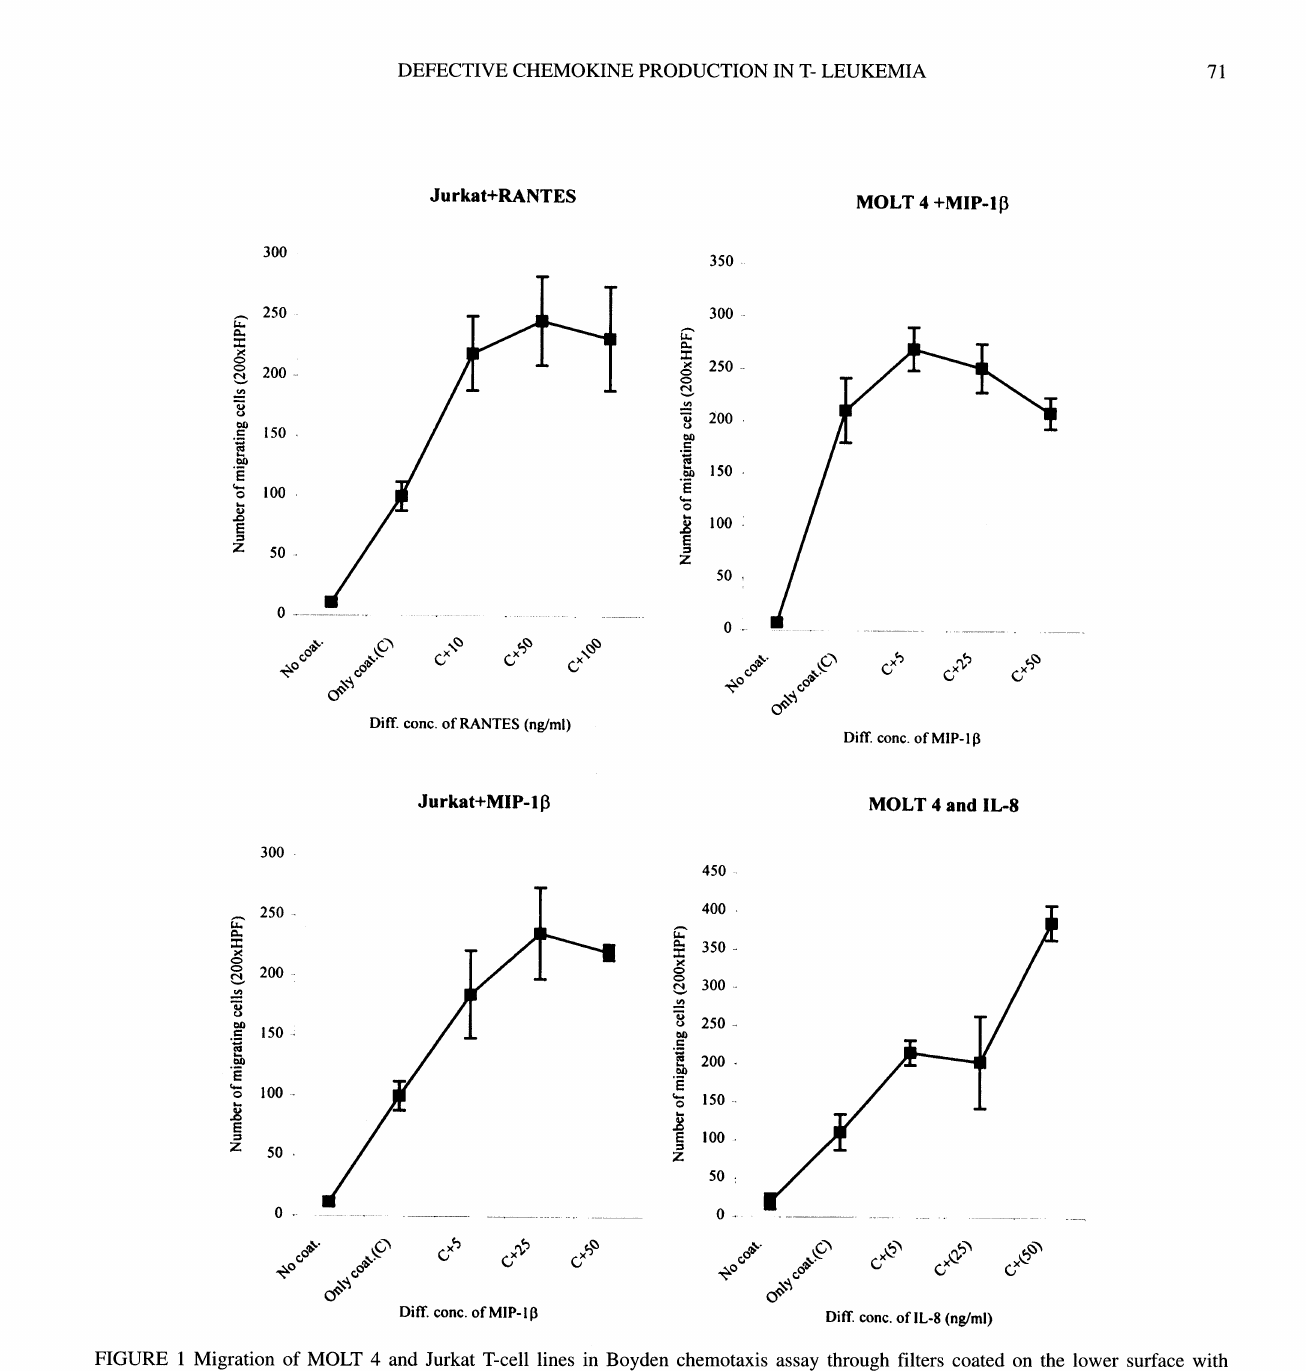
Locomotor behaviour of T-leukemia cell lines The motile behaviour of the T-leukemia cell lines MOLT 4 and Jurkat on fibronectin in the absence and